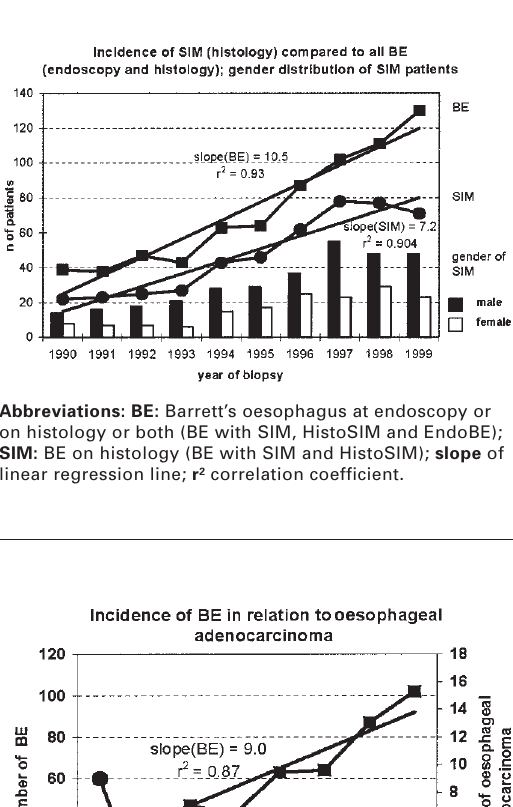
The detection rate of oesophageal adeno- carcinoma of the oesophagus (dots) was nearly constant (slope of regression line [Adeno-Ca] = 0.2), while there was a 2.6-fold increase in BE (squares) from 1990 to 1997 (slope of regression [BE] =